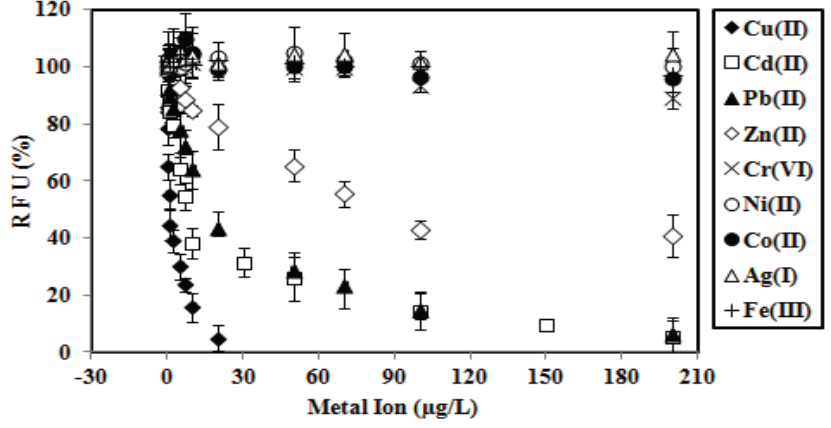
Figure 2. Selectivity performance of the immobilized GFP E. coli by Cu(II), Cd(II), Pb(II), Zn(II), Cr(VI), Co(II), Ni(II), Ag(I) and